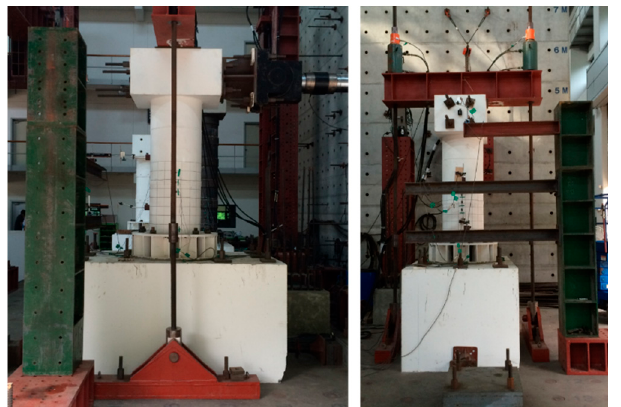
Figure 21. Setup of specimen.